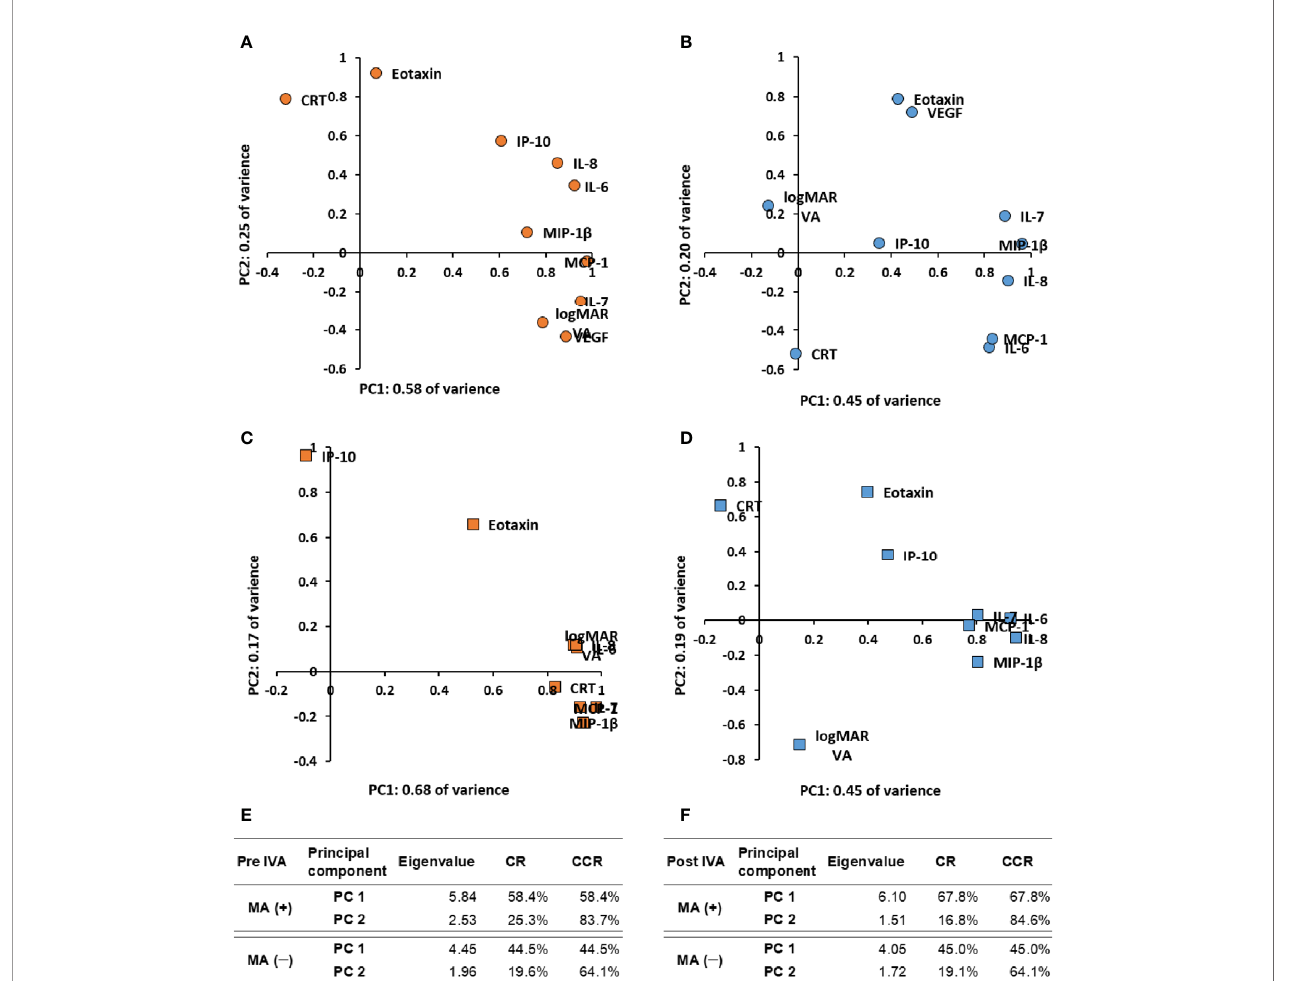
FIGURE 3 | Expression patterns of visual acuity, central macula thickness, and aqueous humor cytokines by principal component analysis in nAMD eyes with or without development of macular atrophy under a fl ibercept treatment. Biplots of PCLs in PC1 and PC2 of (A) MA (+) group pre-IVA, (B) MA ( − ) group pre-IVA, (C) MA (+) group post-IVA, and (D) MA ( − ) group post-IVA are shown. Eigenvalues, CR, and CCR of PC1 and PC2 are presented in (E) MA (+) group and MA ( − ) group pre- IVA and (F) MA (+) group and MA ( − ) group post-IVA. CCR, cumulative contribution ratio; CR, contribution ratio; IVA, intravitreal injection of a fl ibercept; MA, macular atrophy; nAMD, neovascular age-related macular degeneration; PC, principal component; PCL, principal component loading; PC1, fi rst principal component; PC2, second principal